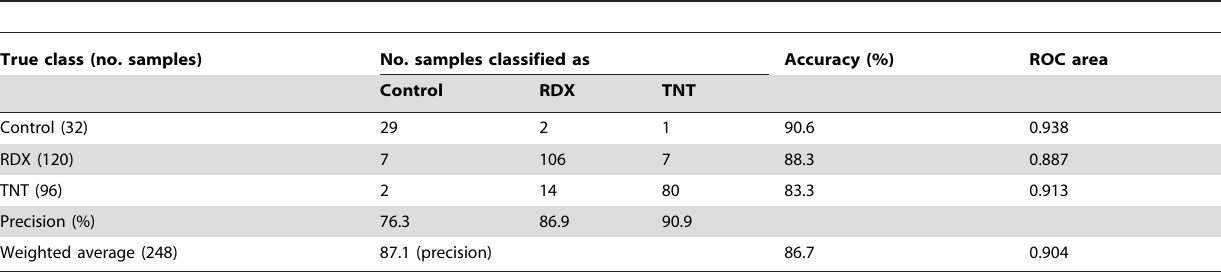
Table 2. Confusion matrix showing classification results for testing datasets obtained by MC-SVM using the optimized set of 39 classifier genes.